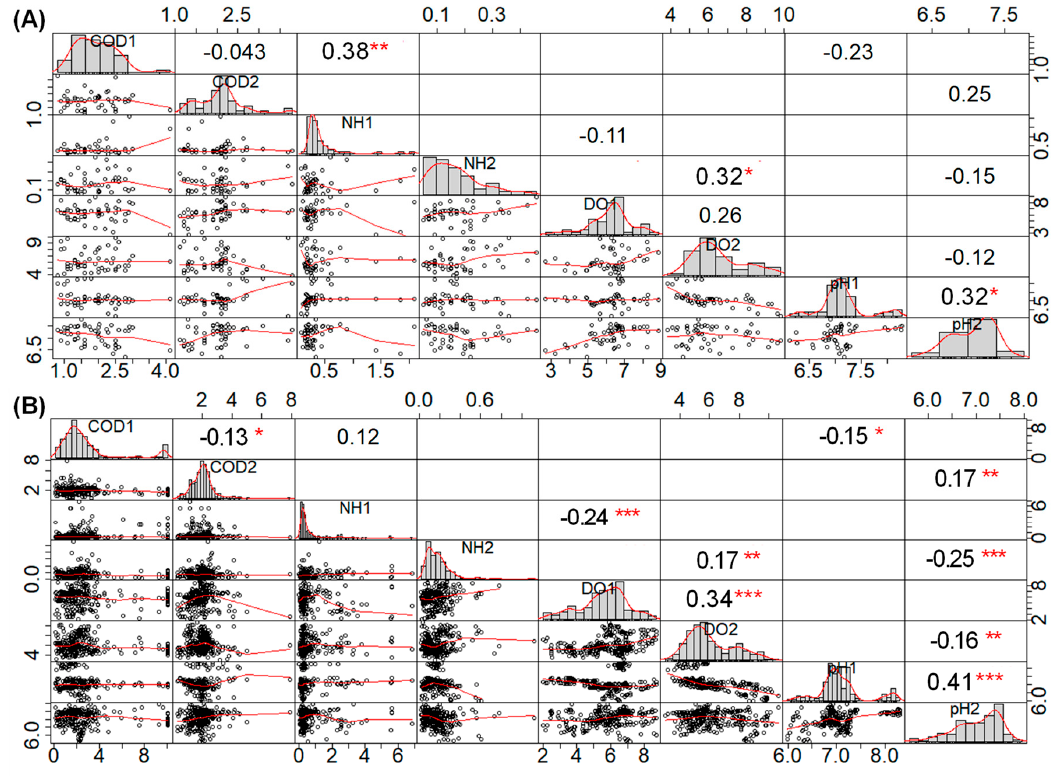
Figure 12. Spearman Correlation analyses between each two of weekly means ( A ) and daily means ( B ) of COD Mn , NH 3 –N, DO, and pH at Sites HuN3 and HuN4 in 2016. Note: COD represents COD Mn , NH represents NH 3 –N. COD1, NH1, DO1 and pH1 belong to Site HuN3. COD2, NH2, DO2 and pH2 belong to Site HuN4. * represents p < 0.05; ** represents p < 0.01; *** represents p < 0.001. Circles represent data samples; the blacker the circles are, the denser the data are. The diagonal figures with gray rectangles represent frequency distribution histograms of each variable.